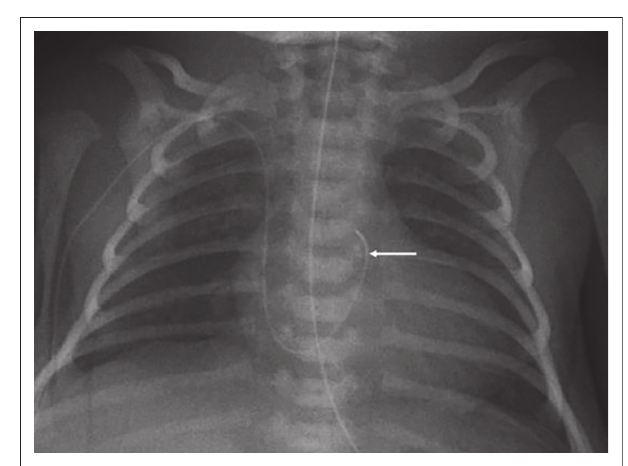
FIGURE 13: Patient with right-sided pneumothorax (arrow). The right ICD is, however, not lying within the pleural space. It is lying instead in the soft tissues outside the thoracic cavity, and thus the pneumothorax remains.